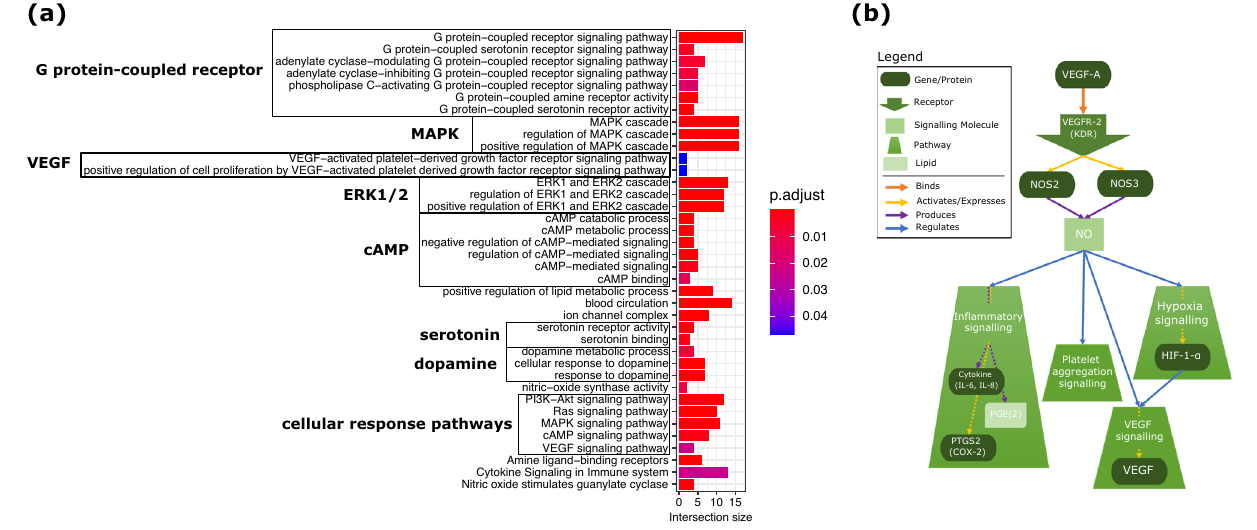
Figure 4. Biological mechanisms targeted by the common neighbor DTIs. (a) Enrichment analysis of the targets in our “common neighbor DTIs”. The bar plot is showing the enrichments related to G protein-coupled receptors; MAPK cascade; VEGF and ERK1/2; cAMP/cGMP signaling; lipid metabolism and blood circulation; ion channel activity and response to amine ligand-binding, particularly serotonin and dopamine; cellular response pathways and terms linked with amine ligand-binding receptors, cytokine and nitric oxide (NO) signaling. The complete list can be found in Supplementary Table S11. The intersection size (on horizontal axis) is the number of genes in our “common neighbor DTIs” that are annotated with the corresponding GO term or pathway from KEGG or REACTOME (on the vertical axis). The adjusted p-value, “p.adjust”, is obtained by the Set Counts and Sizes correction method. This method considers the dependency of multiple tests by taking into account the overlap of functional terms (on colorbar). (b) Illustration of how the enriched pathways are tied to NO and VEGF signaling, showing that NO production is directly related to VEGFR-2 receptor and at the same time NO regulates VEGF signaling pathway among others: inflammatory signaling, hypoxia signaling and platelet